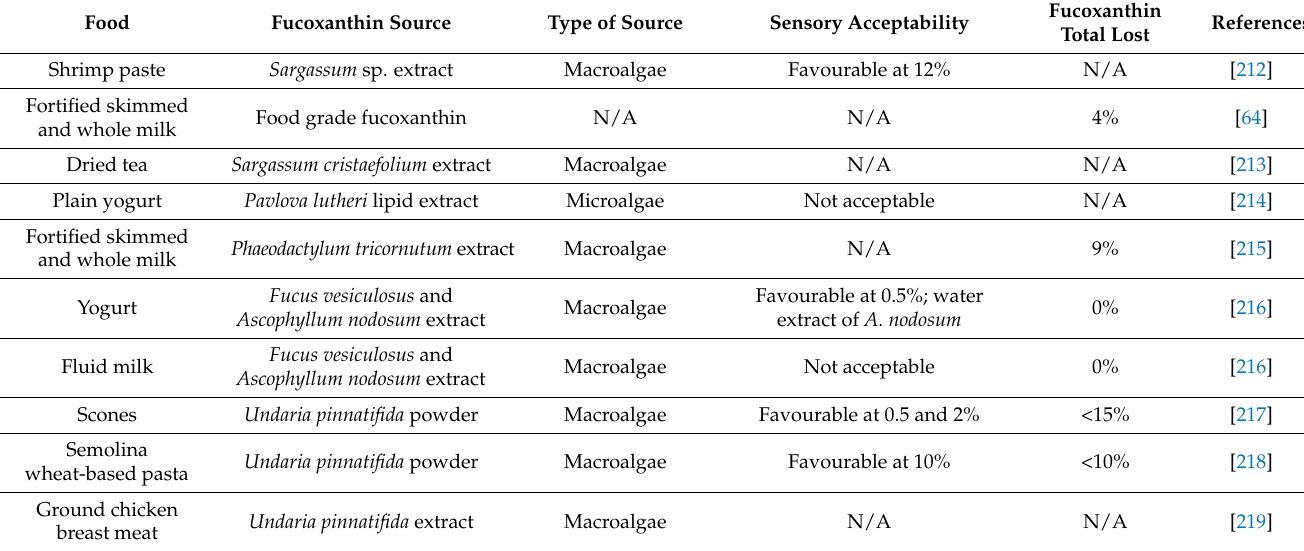
Table 3. Summary of different food products incorporated with fucoxanthin as functional